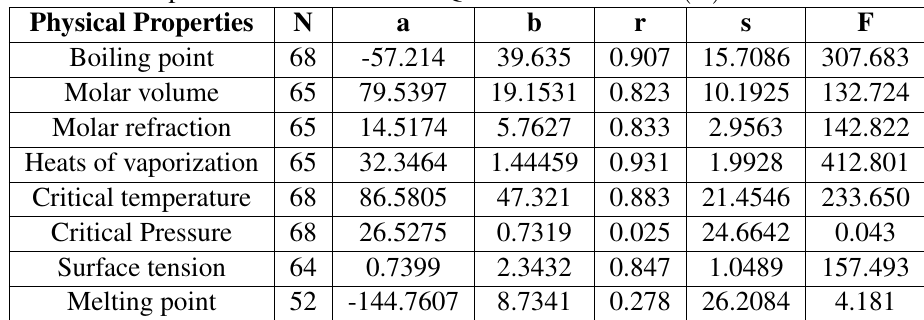
Table 10. Statical parameters for the linear QSPR model for SCE ( G )